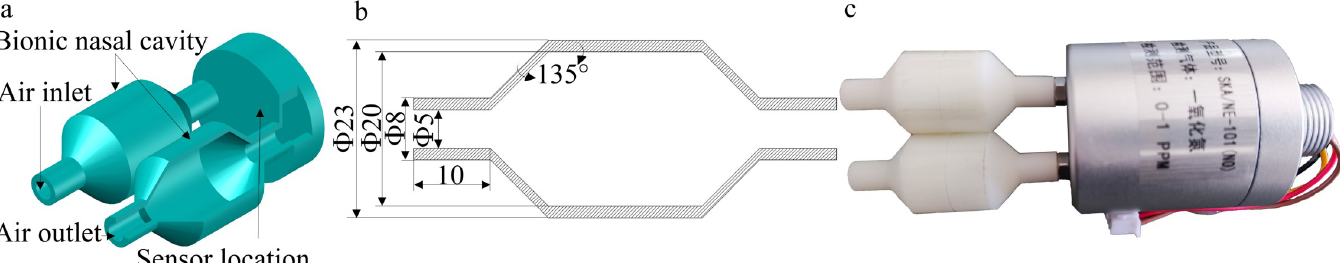
Fig 2. General cavity of the electronic nose system for bionic canine olfaction. (a) Structural diagram of Chamber A. (b) Longitudinal section of Chamber A. (c) Actual picture of Chamber A.